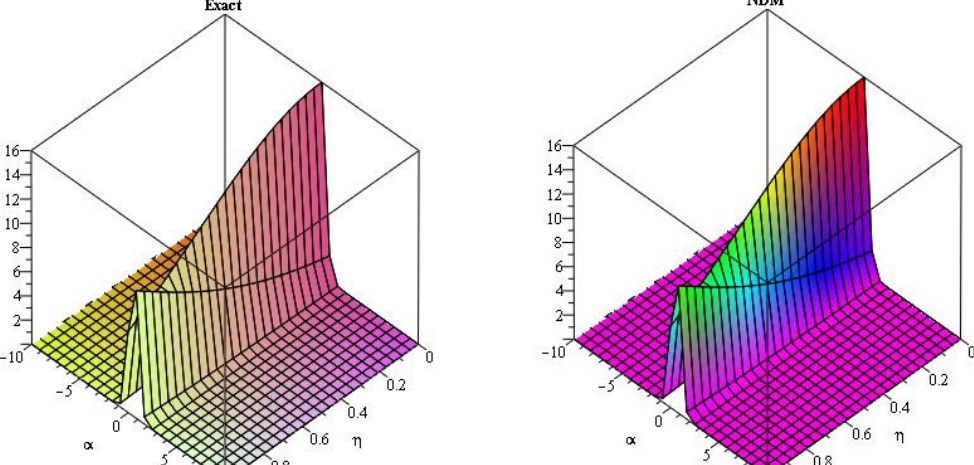
Figure 1. Exact and NDM solution of µ ( α , η ) at δ = 1.